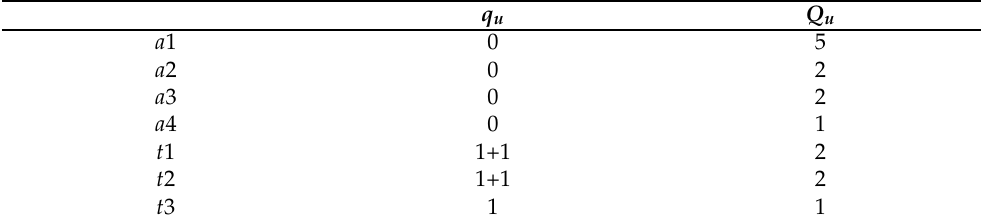
Figure 15. Interference graph G aug . Table 5. Global and local traffic